Question: Identify the chart type used in this figure.
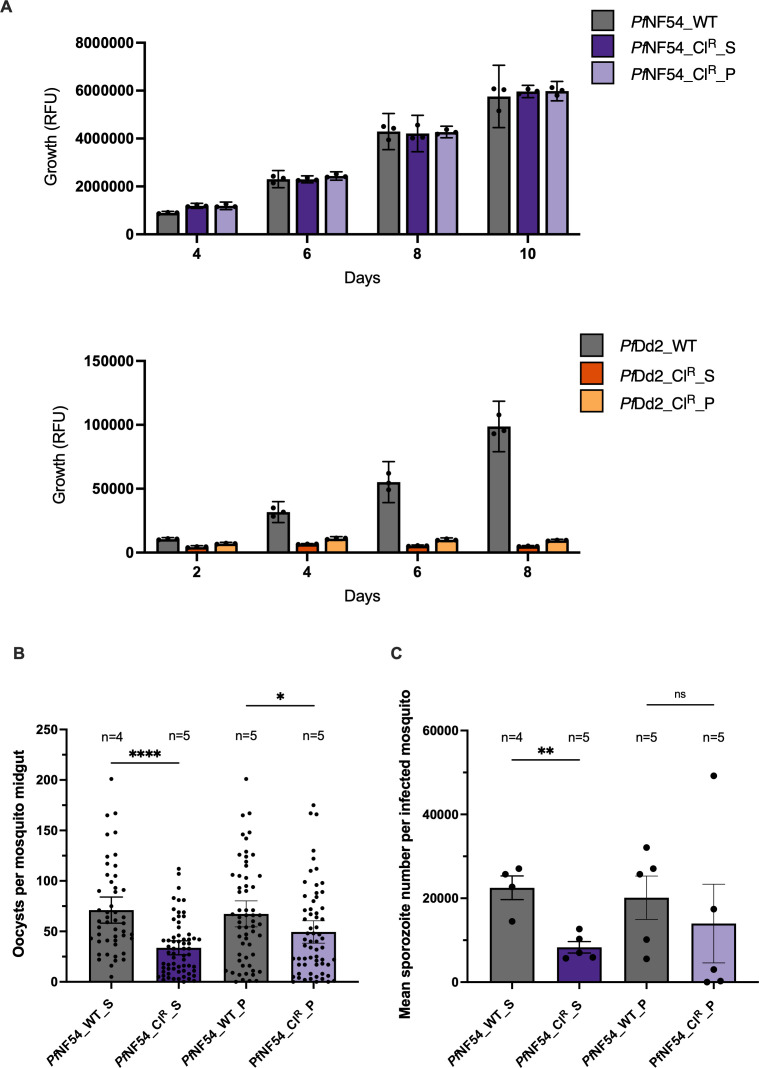
Answer: bar